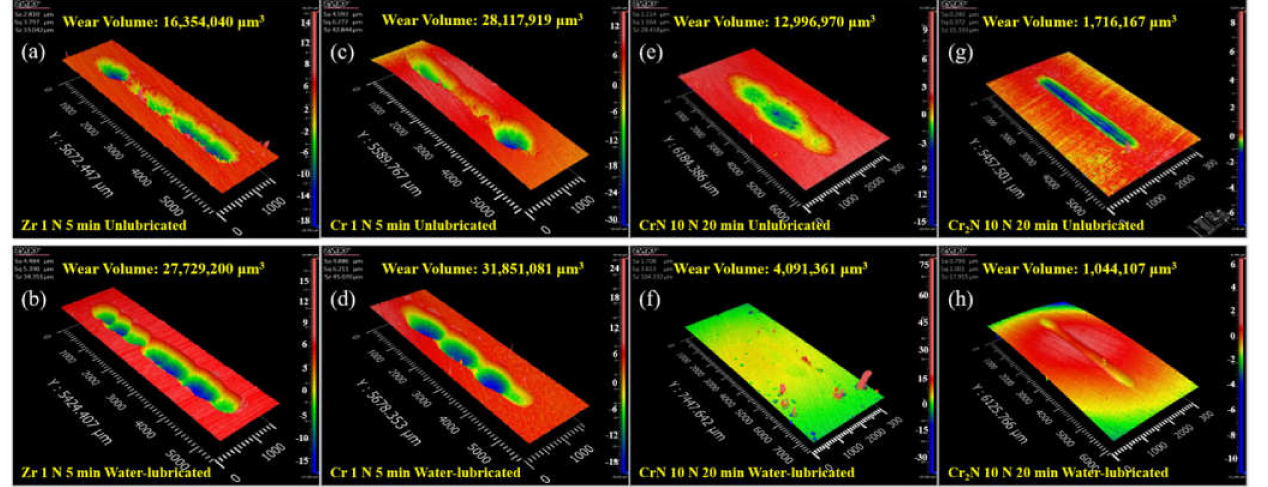
Figure 7. Results of the non-contact 3D laser interferometry of the ( a , b ) Zr-4 alloy, ( c , d ) Cr, ( e , f ) CrN and ( g , h ) Cr 2 N coatings.